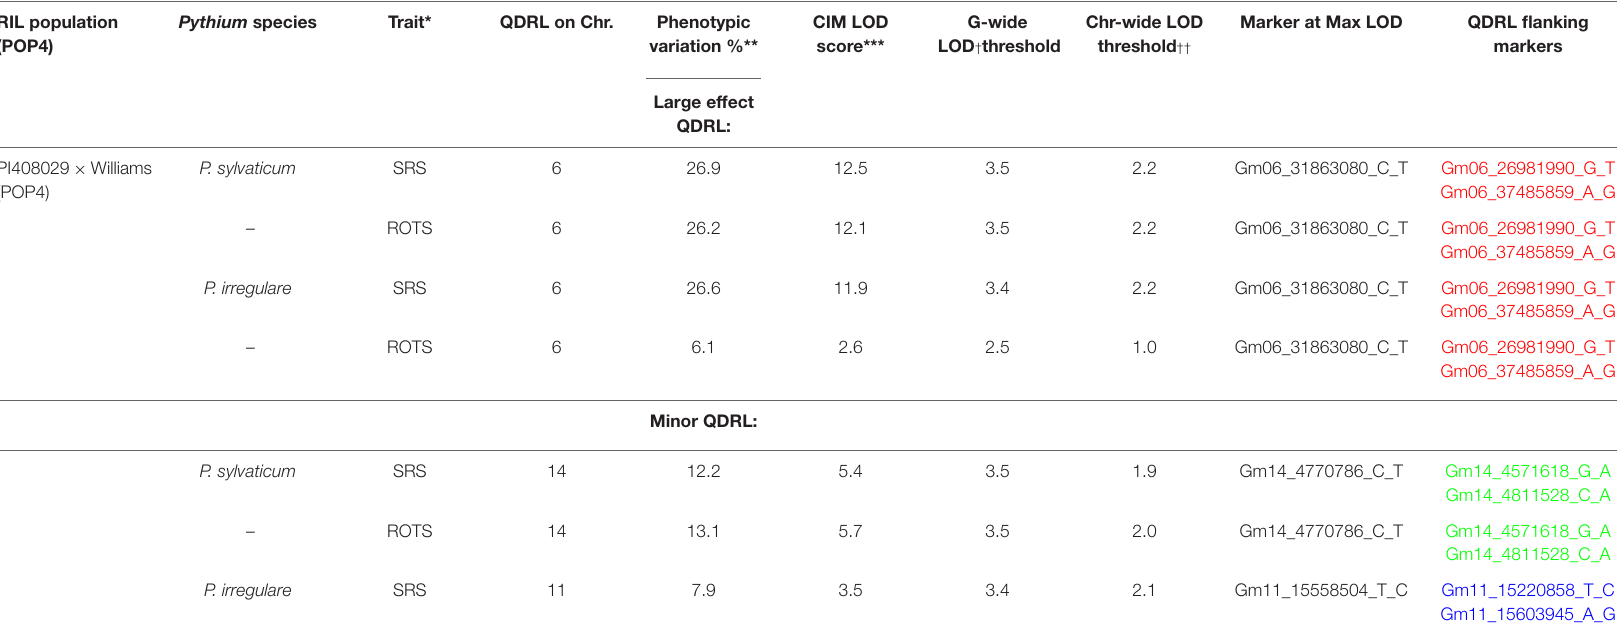
TABLE 5 | Quantitative disease resistance loci detected using composite interval mapping in POP4 for Pythium sylvaticum and Pythium irregulare . RIL population Pythium species Trait* QDRL on (POP4)